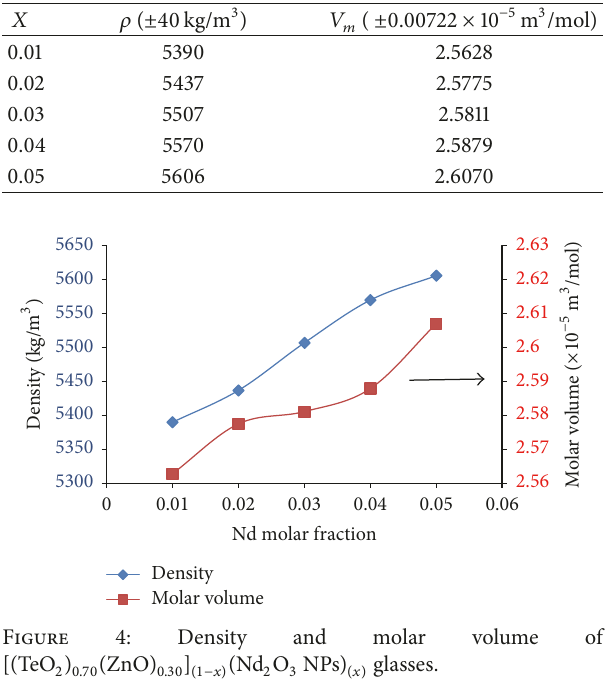
Figure 4: Density and molar volume of [(TeO 2 ) 0.70 (ZnO) 0.30 ] (1−𝑥) (Nd 2 O 3 NPs) (𝑥) glasses.